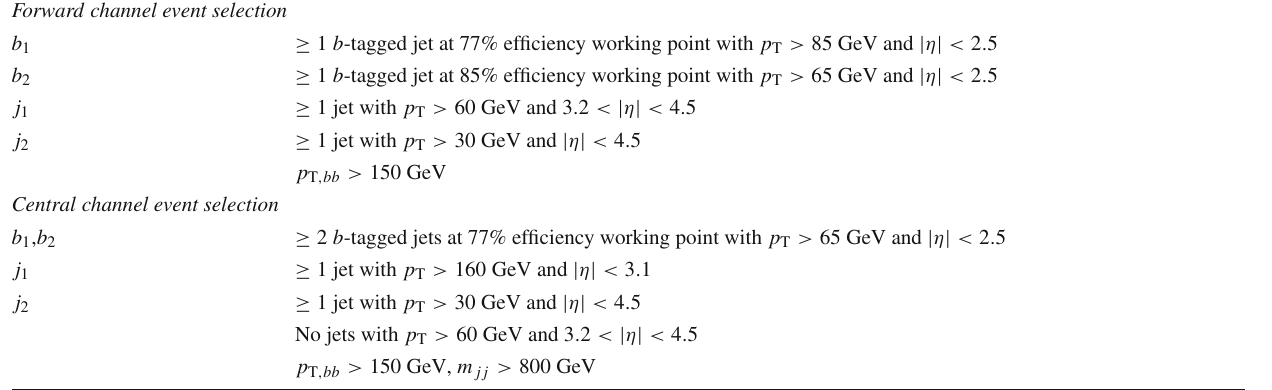
Table 1 Event selection criteria for the two channels used in this analysis. The p T and | η | requirements on the jets are used to match trigger selections and flavour-tagging